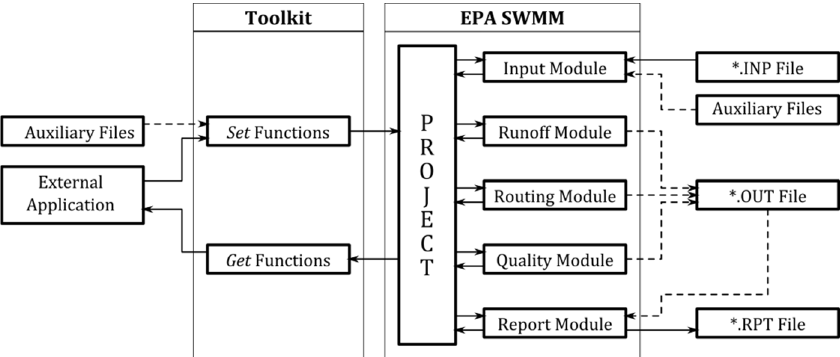
Figure 1. Block diagram of EPA SWMM and the Toolkit.